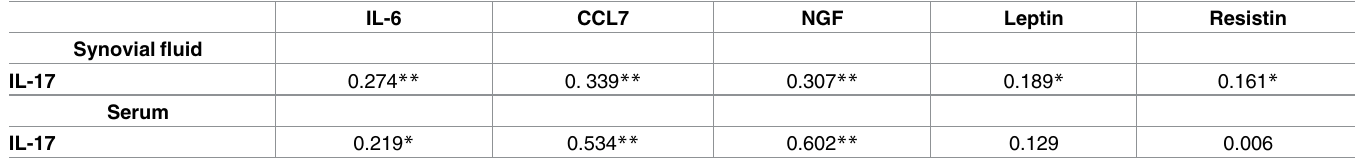
Table 4. Correlation between synovial fluid and serum IL-17 and the concentrations of adipokines and cytokines that show significant elevation in the cohort of patients with detectable synovial fluid IL-17.